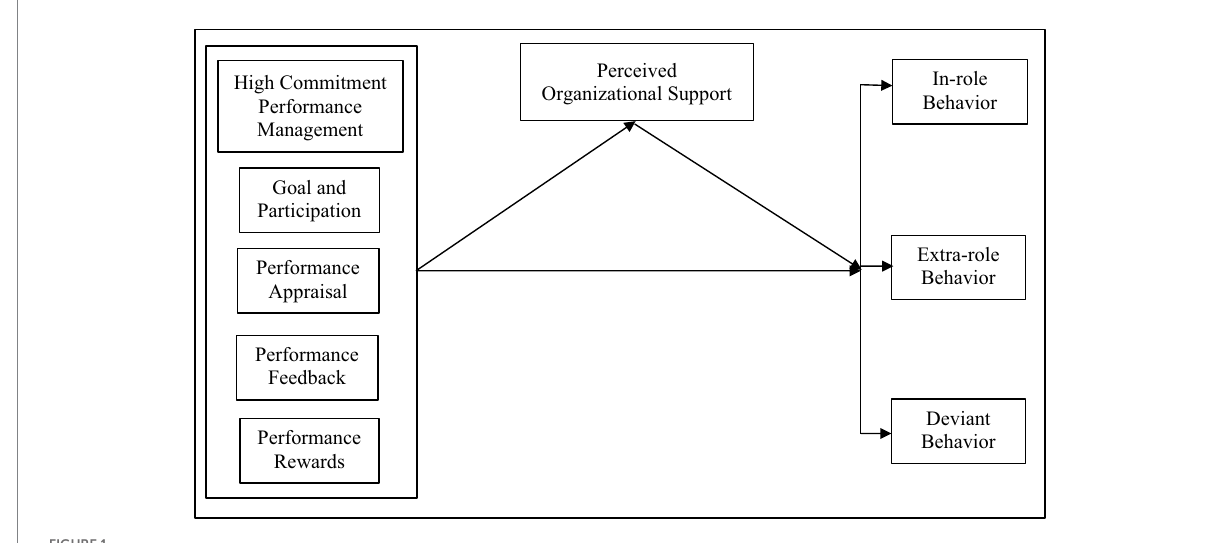
FIGURE 1 Our research